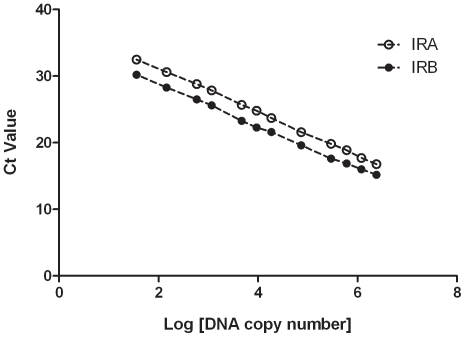
IR-A and IR-B assay serial dilution curves.Probe sensitivity was tested by performing IR-A or IR-B TaqMan qRT-PCR assays with a serial dilution of approximately 107 to 10 copies of plasmid DNA of either IR-A, IR-B, or an empty vector control. The Y axis represents cycle-threshold (Ct) values and the X axis represents log DNA copy number. The slope and regression coefficient (r
2 value) of the standard dilution curve for the IR-A assay are -3.259 and 0.9992, respectively. The slope and regression coefficient (r
2 value) of the standard dilution curve for the IR-B assay are -3.155 and 0.9989, respectively.